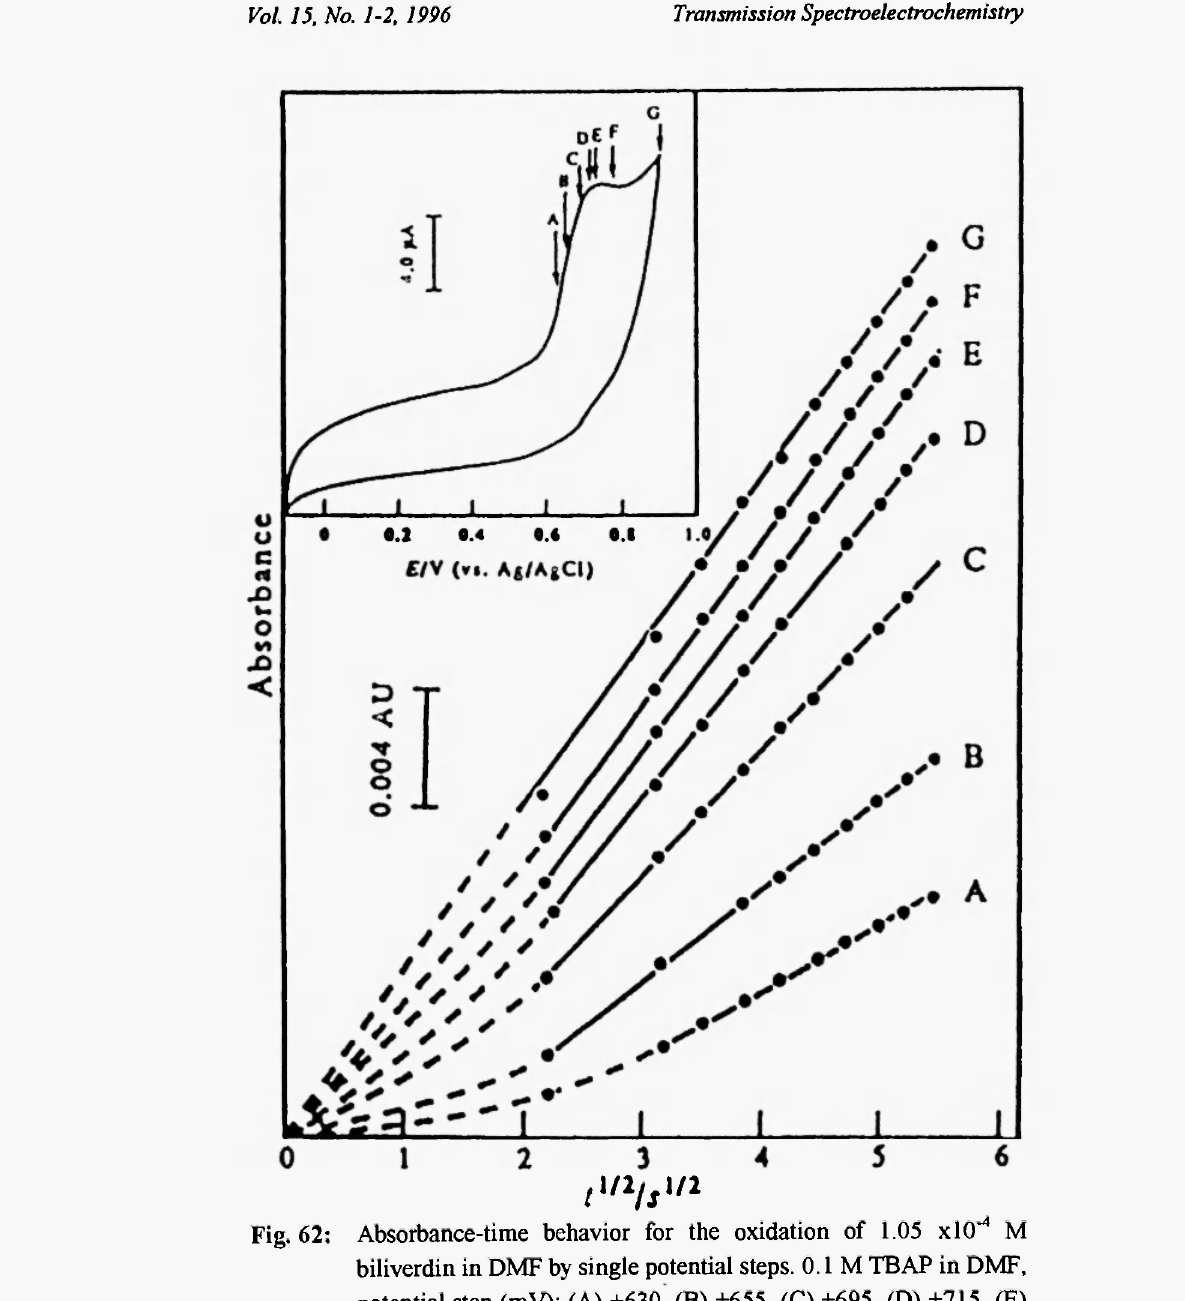
Fig. 62: Absorbance-time behavior for the oxidation of 1.05 xlO" Μ biliverdin in DMF by single potential steps. 0.1 Μ TB AP in DMF, potential step (mV): (A) +630, (B) +655, (C) +695, (D) +715, (E) +730, (F) +775, and (G) +900. The inset shows thin-layer cyclic voltammogram of 9.65 χ 10' 5 Μ biliverdin in DMF, scan rate: 5.0 mV/s. (From Ref.